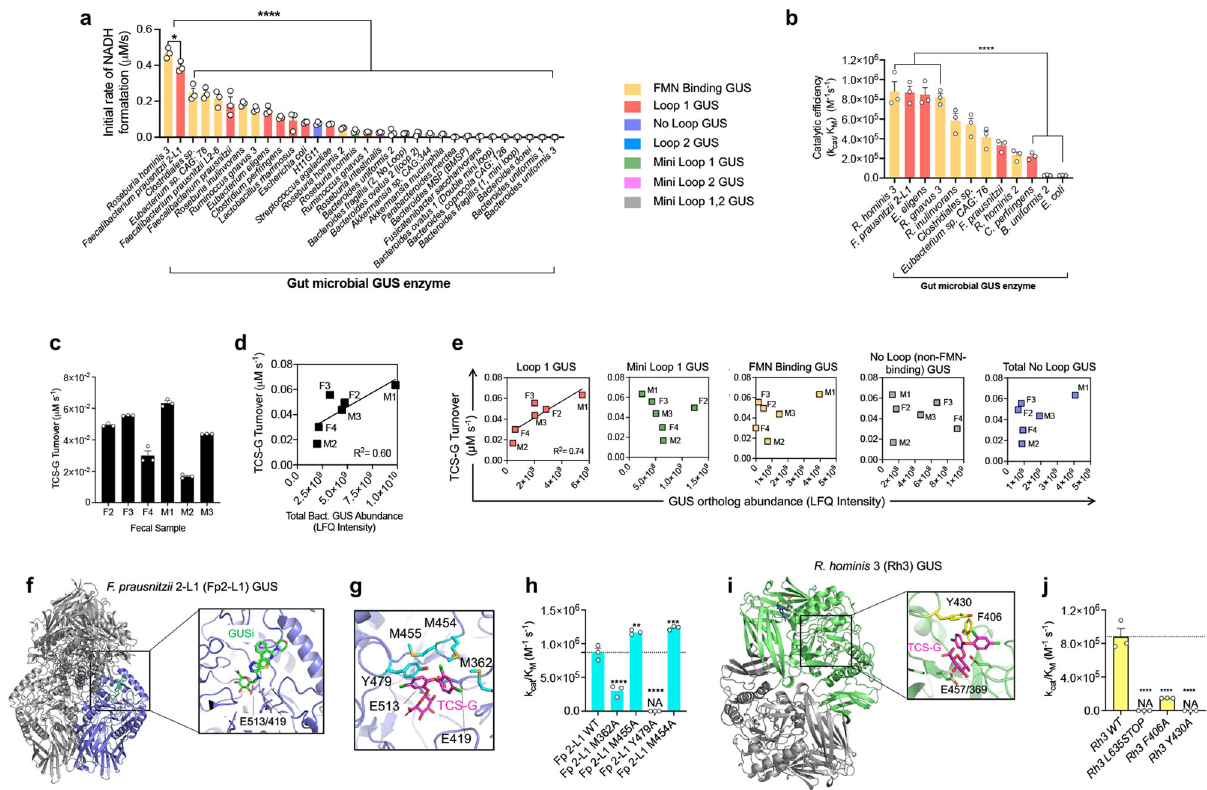
Fig. 3 Speci fi c gut microbial glucuronidase enzymes convert TCS-G to TCS. a Screening a panel of 32 puri fi ed gut microbial β -glucuronidase (GUS) proteins representing seven structural clades using a coupled assay reveals that Loop 1 and FMN-binding GUS orthologs ef fi ciently convert TCS-G to TCS in vitro. b Catalytic ef fi ciency values determined by HPLC further indicate that Loop 1 and FMN-binding GUS orthologs show high TCS-G to TCS-conversion activities in vitro. c Enzymes extracted from human fecal samples exhibit variable TCS-G to TCS turnover rates ex vivo. d The abundance of total bacterial GUS enzymes identi fi ed in human fecal samples by activity-based probe-enabled proteomics is correlated with TCS-G turnover rate. e The abundance of Loop 1 GUS proteins identi fi ed in human fecal samples by activity-based probe-enabled proteomics, but not other types of GUS, is correlated with TCS-G turnover rate. f Crystal structure of F. prausnitzii 2-L1 (Fp2-L1) GUS with the overall enzyme tetramer shown (purple, gray) and a close-up of the GUSi- glucuronic acid conjugate (green) bound at the enzyme ’ s active site with the catalytic glutamates highlighted. g TCS-G docked into the active site of Fp2-L1 GUS with residues selected for mutagenesis studies highlighted in cyan. h Catalytic ef fi ciency values of wild-type (WT) and Fp2-L1 GUS mutant proteins. i Crystal structure of Rh3 GUS dimer (green, gray) with FMN bound (highlighted in blue in top monomer). Inset: TCS-G (magenta) was docked using Schrödinger and was found proximal to Y430 and F406 (yellow) at the Rh3 GUS active site (catalytic residues in green). j Catalytic ef fi ciency values for Rh3 GUS mutants showing that the C-terminal domain, Y430 and F406 are important for TCS-G processing. The data are mean ± SEM, n = 3 biological replicates. All statistics were calculated using one-way ANOVA with Tukey ’ s multiple comparisons test. * P < 0.05, ** P < 0.01, *** P < 0.001, **** P < 0.0001. NA no activity. Source data are provided with this paper. TCS triclosan, TCS-G triclosan-glucuronide, GUS β